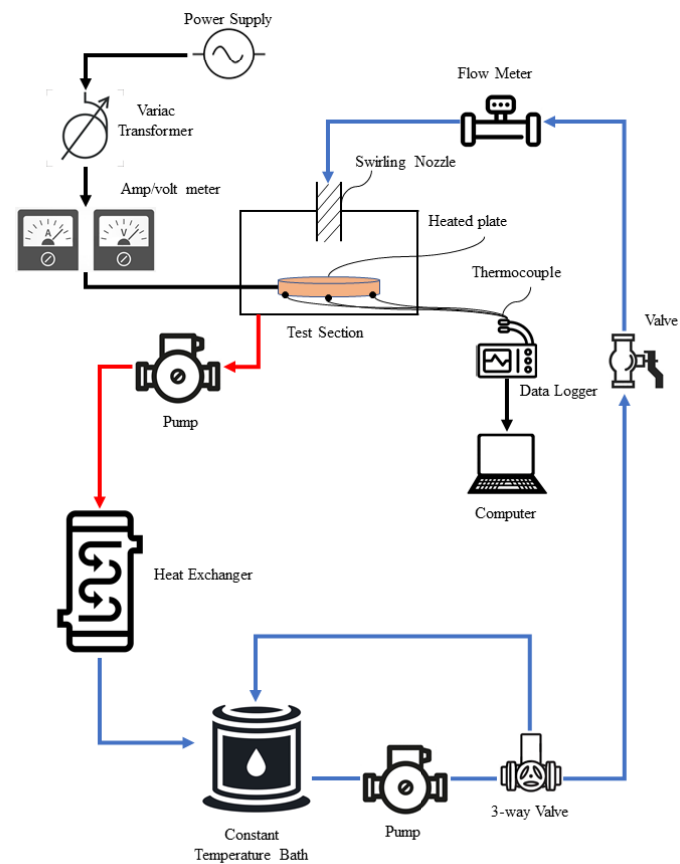
Figure 5. Schematic diagram of the experiment setup.